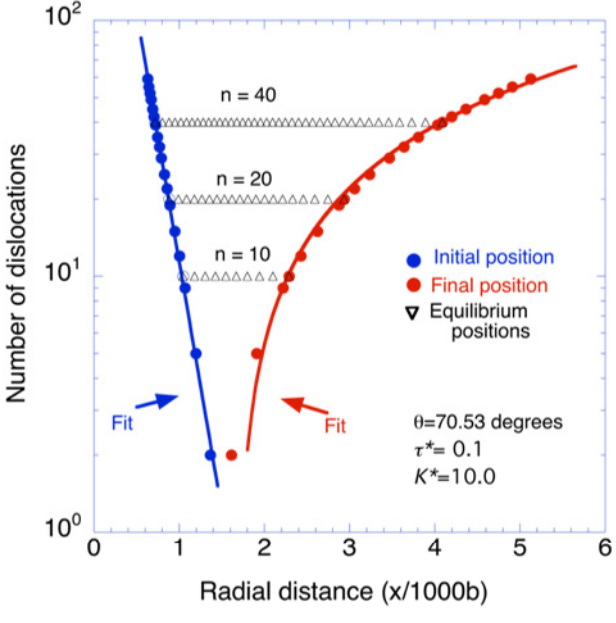
Figure 9. The diagram showing initial, final and equilibrium positions of